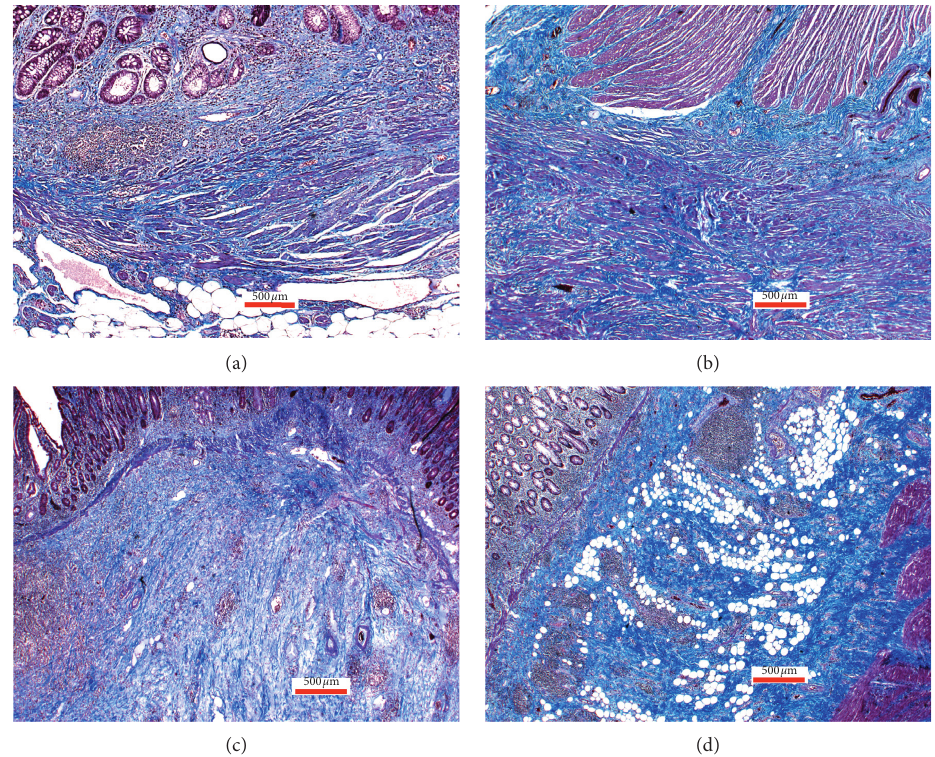
Figure 2: Example of cell cytoplasmatic staining of macrophages using the CD68 immunohistochemical